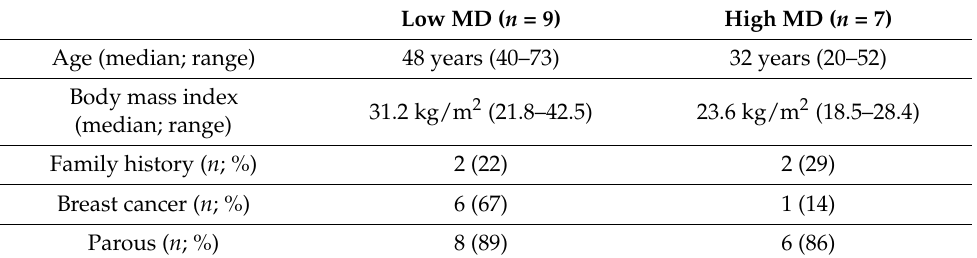
Table 1. Patient